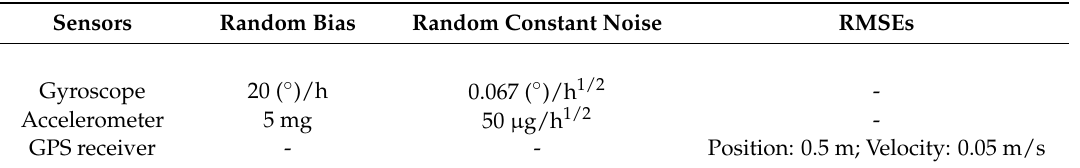
Table 1. Main technological parameters of IMU and